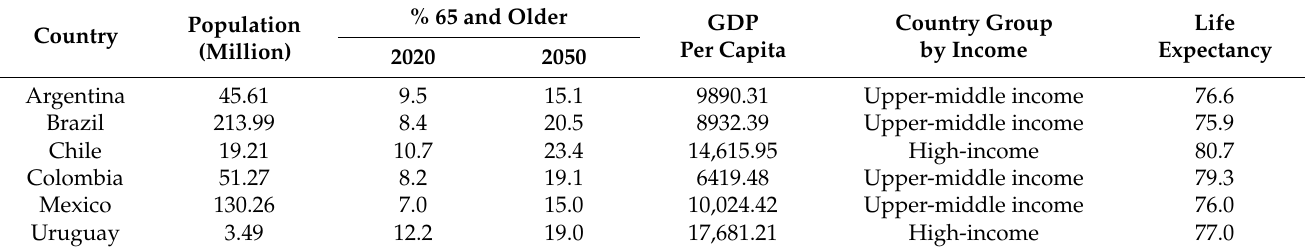
Table 1. Main indicators for countries selected; 2020 or latest year